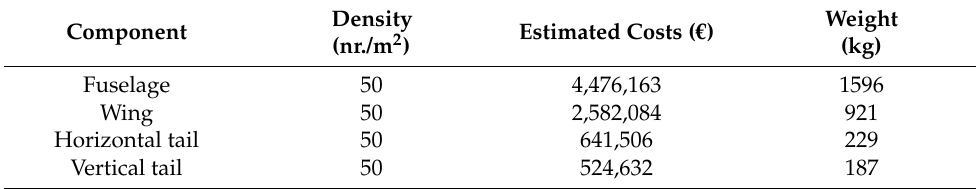
Table 18. SHM system